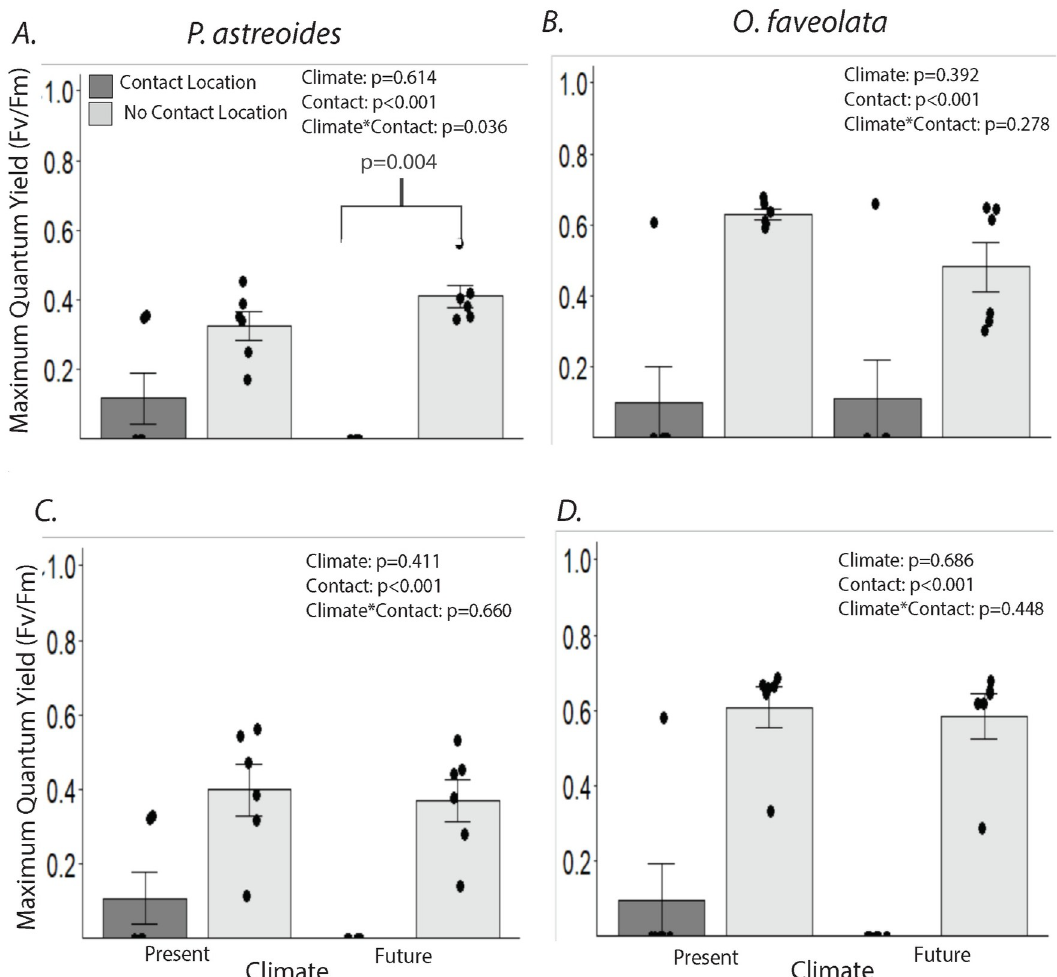
Fig 3. Effects of climate and coral-coral competition on endosymbiont photosynthetic efficiency (F v /F m ). Maximum quantum yield values (means ± SE) for (A) Porites astreoides in contact with Orbicella faveolata at the location of direct contact (Contact Location) vs. 3 cm away from area of direct contact (No Contact Location) at day 7, (B) O . faveolata in contact with P . astreoides at the Contact Location vs. No Contact Location at day 7, (C) P . astreoides in contact with O . faveolata at the Contact Location vs. No Contact Location at day 14, and (D) O . faveolata in contact with P . astreoides at the Contact Location vs. No Contact Location at day 14. Analyzed with two-way ANOVAs comparing contact area and climate condition. Dots represent individual data points. The p- value contrasting values between “Contact Location” and “No Contact Location” under future conditions is from one-way ANOVA N = 6.